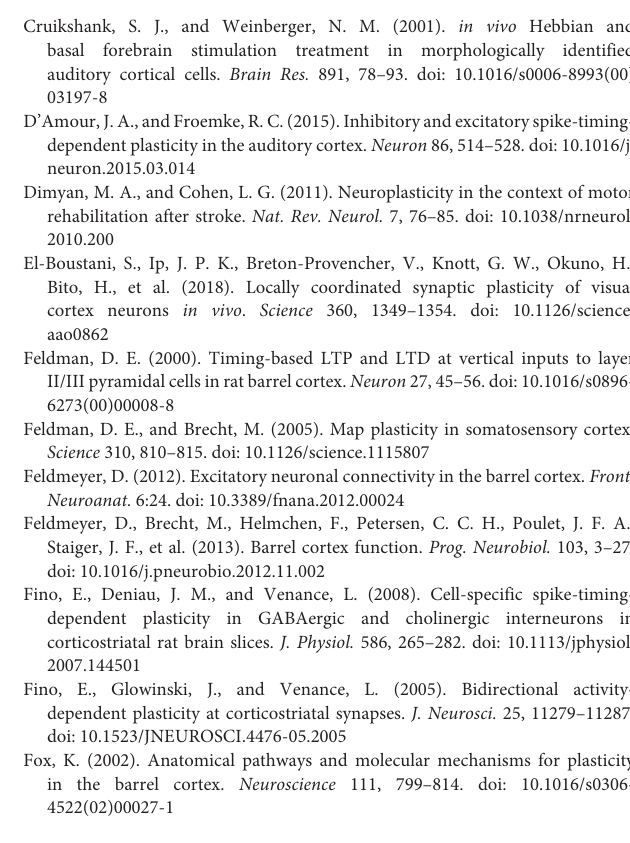
SUPPLEMENTARY FIGURE 1 | Spearman correlation between CI and angular selectivity indices before paired stimulation. (A) DI versus CI in the PW-paired (left panels) and AW-paired (right panels) groups. DI vs. CI in the PW-paired group ( n = 98), PW stimulation: r = − 0.095, p = 0.354, AW stimulation: r = − 0.009, p = 0.927; in the AW-paired group ( n = 83), PW stimulation: r = 0.123, p = 0.267, AW stimulation: r = 0.212, p = 0.055, Spearman correlation. (B) OI versus CI in the PW-paired (left panels) and AW-paired (right panels) groups. OI vs. CI in the PW-paired group, PW stimulation: r = − 0.041, p = 0.691, AW stimulation: r = − 0.026, p = 0.798; in the AW-paired group, PW stimulation: r = − 0.041, p = 0.713, AW stimulation: r = 0.056, p = 0.618, Spearman correlation. SUPPLEMENTARY FIGURE 2 | Spontaneous activity and PW stimulation evoked response properties in optogenetic-leading condition of the PW-paired group before paired stimulation. Spontaneous activity and evoked response, onset latency, and peak latency of PW stimulation from units in three paired direction conditions ( n = 27, 8, 15,